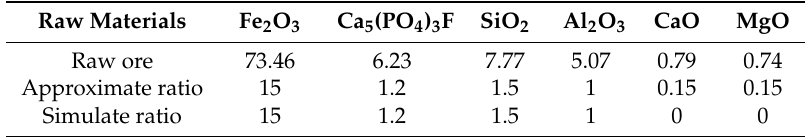
Table 2. The material mass ratio of pure substance simulated high-phosphorus iron ore (mass ratio and mass %).